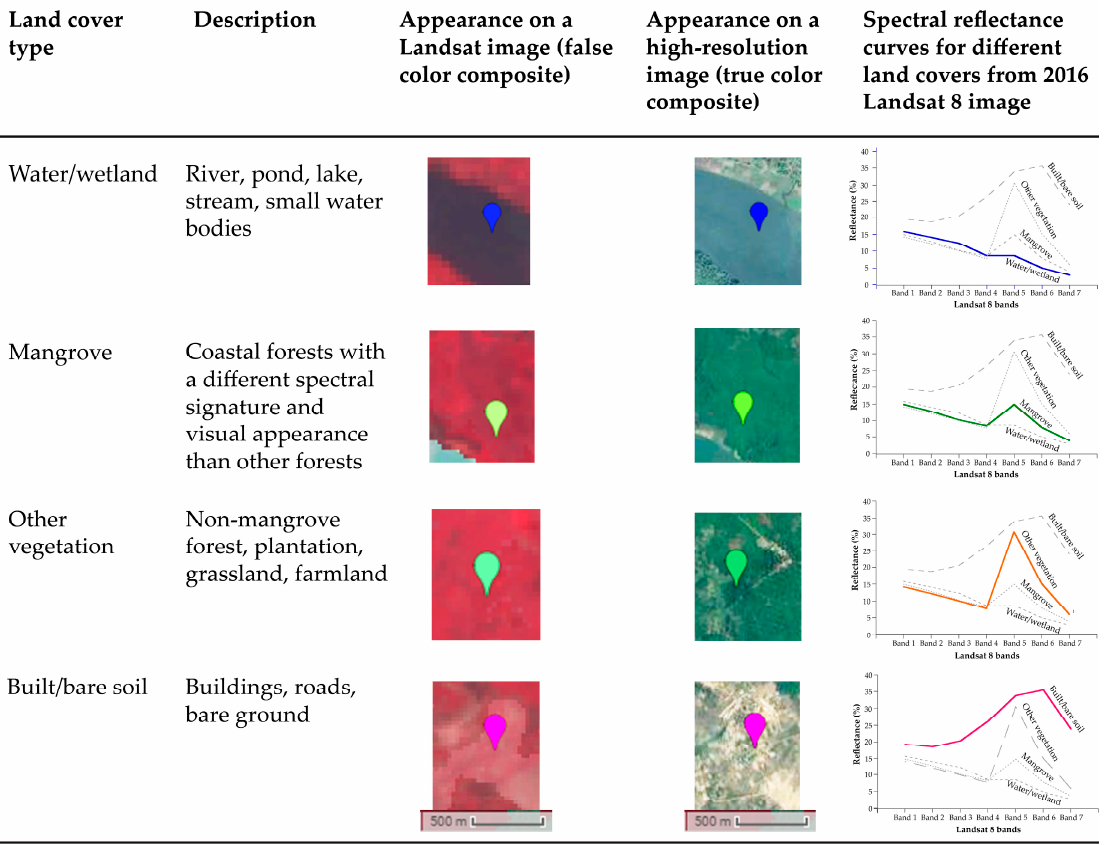
Figure 3. Description of the land cover classes, their appearances on Landsat and high-resolution images, and spectral reflectance curves for representative pixels from each class.